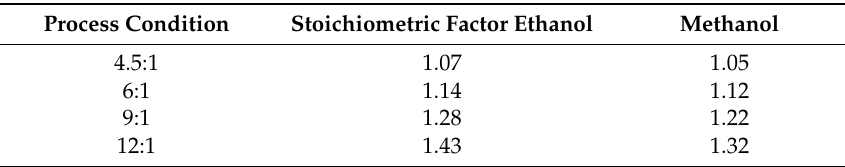
Table 1. Stoichiometric factor.